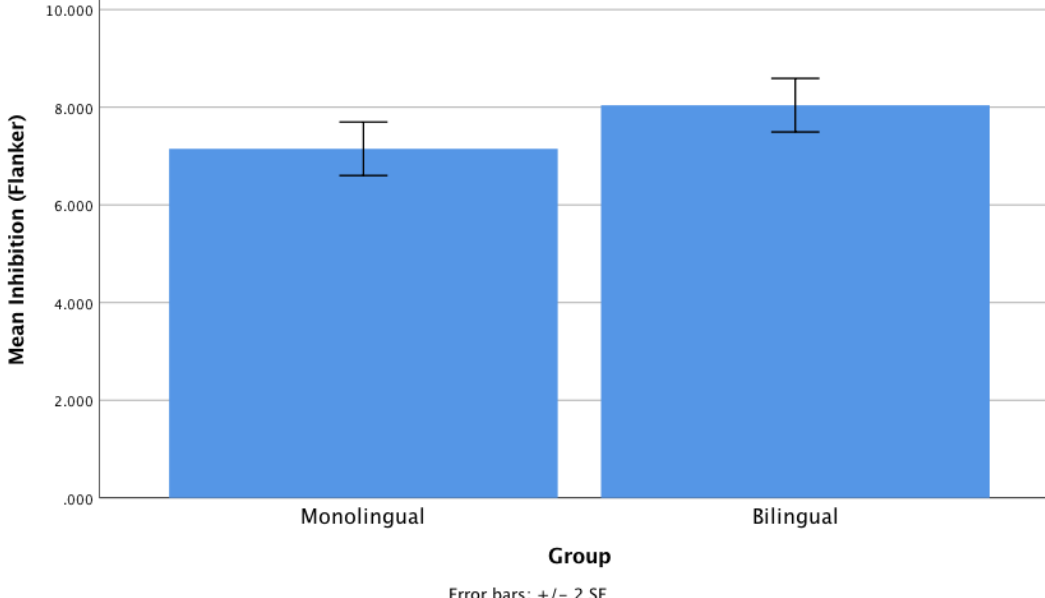
Figure 6. Mean Flanker Scores Compared between Monolingual and Bilingual